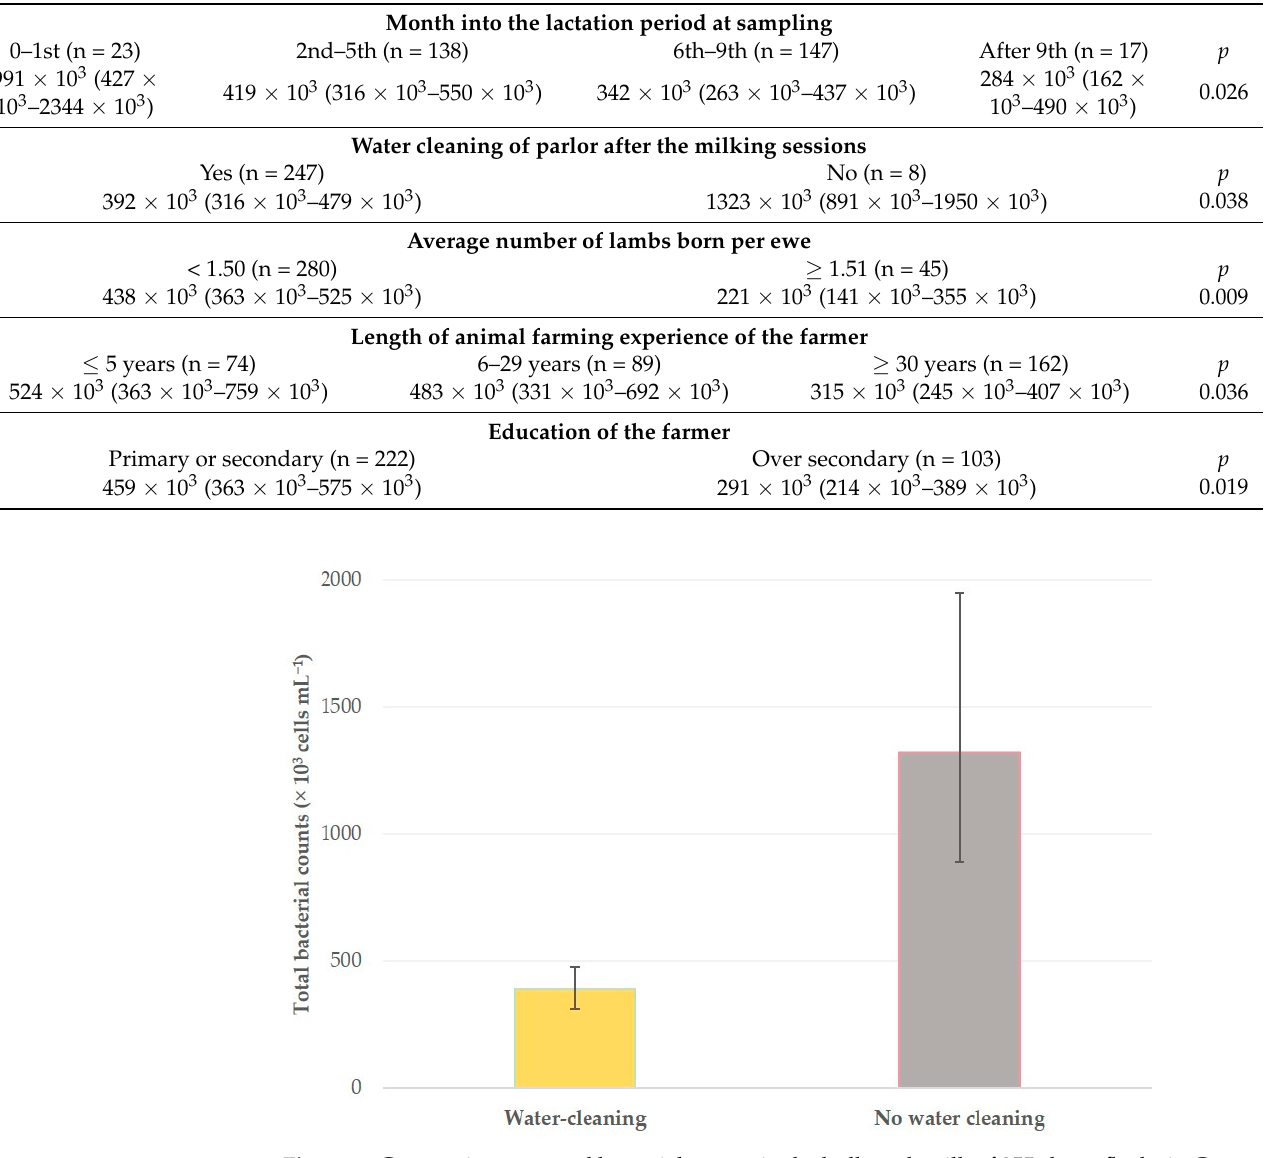
Figure 6. Geometric mean total bacterial counts in the bulk-tank milk of 255 sheep flocks in Greece, in accord with water cleaning of the parlor after completion of the milking procedure (bars indicate 95% confidence intervals of the geometric mean).